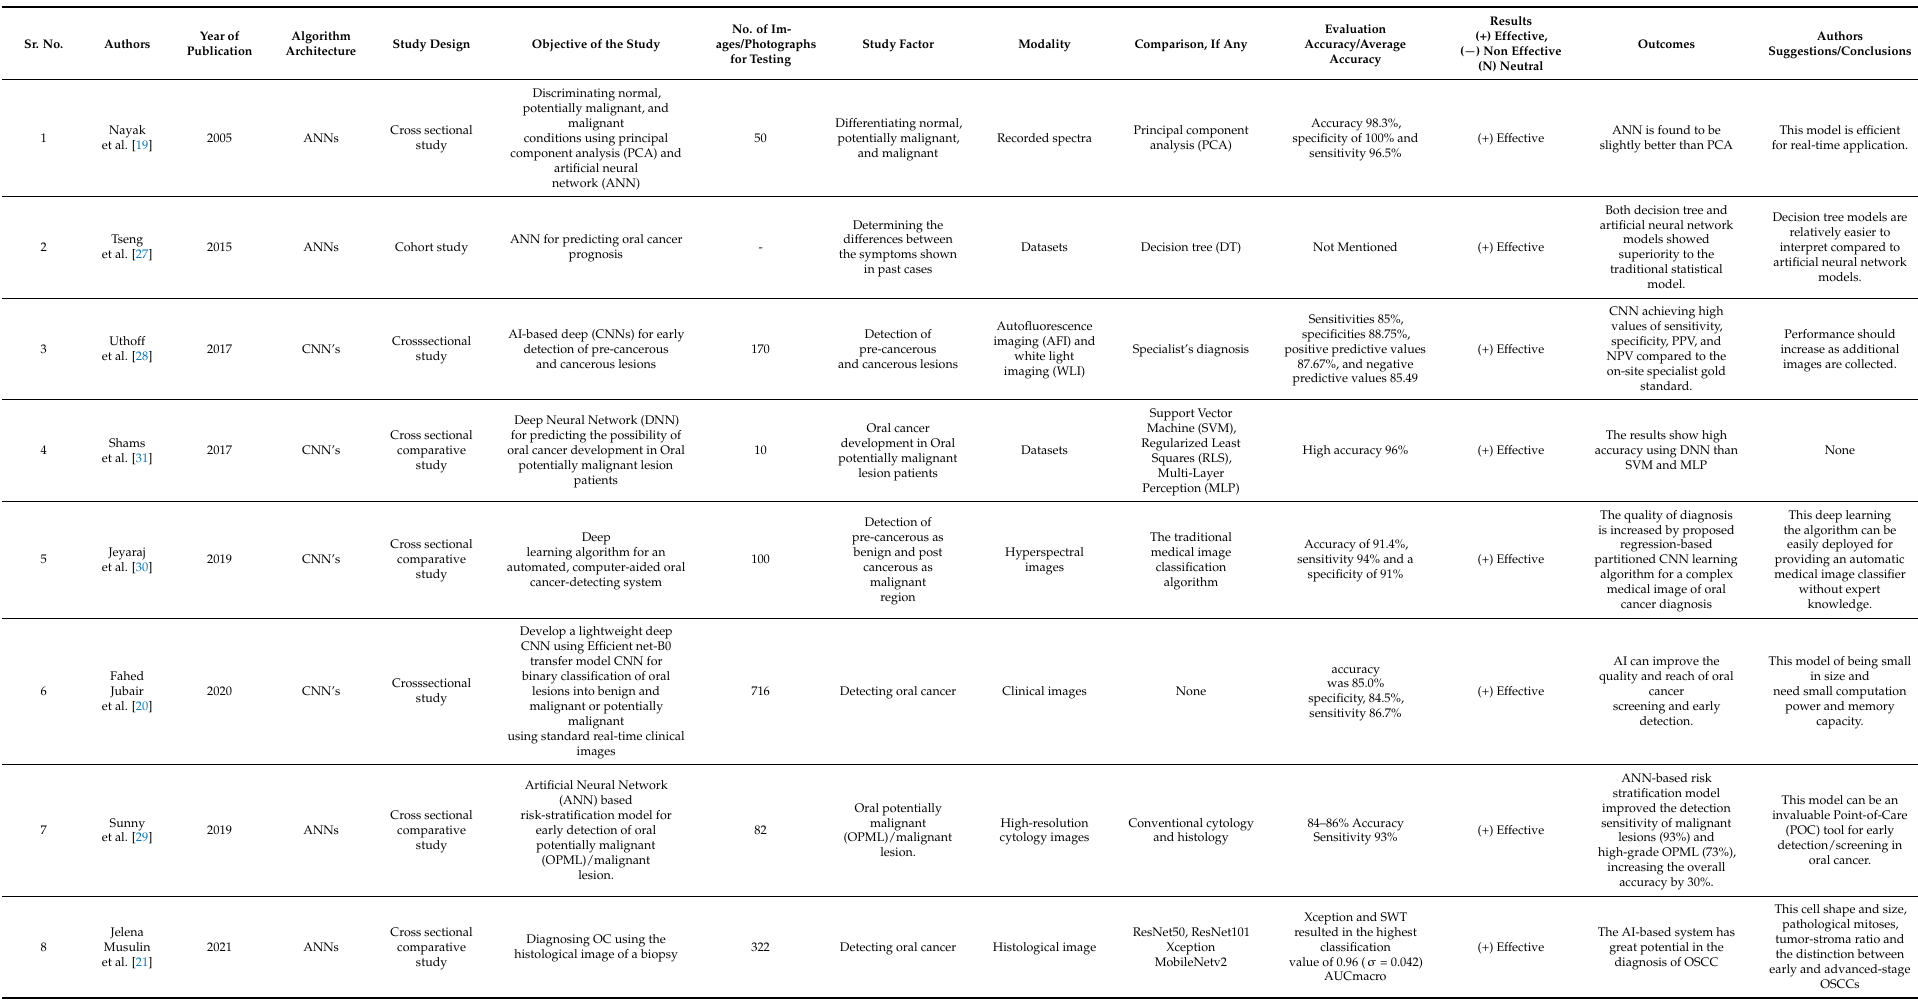
Table 2. Details of the studies that have used AI-based models for oral cancer diagnosis and predicting the prognosis. Sr.